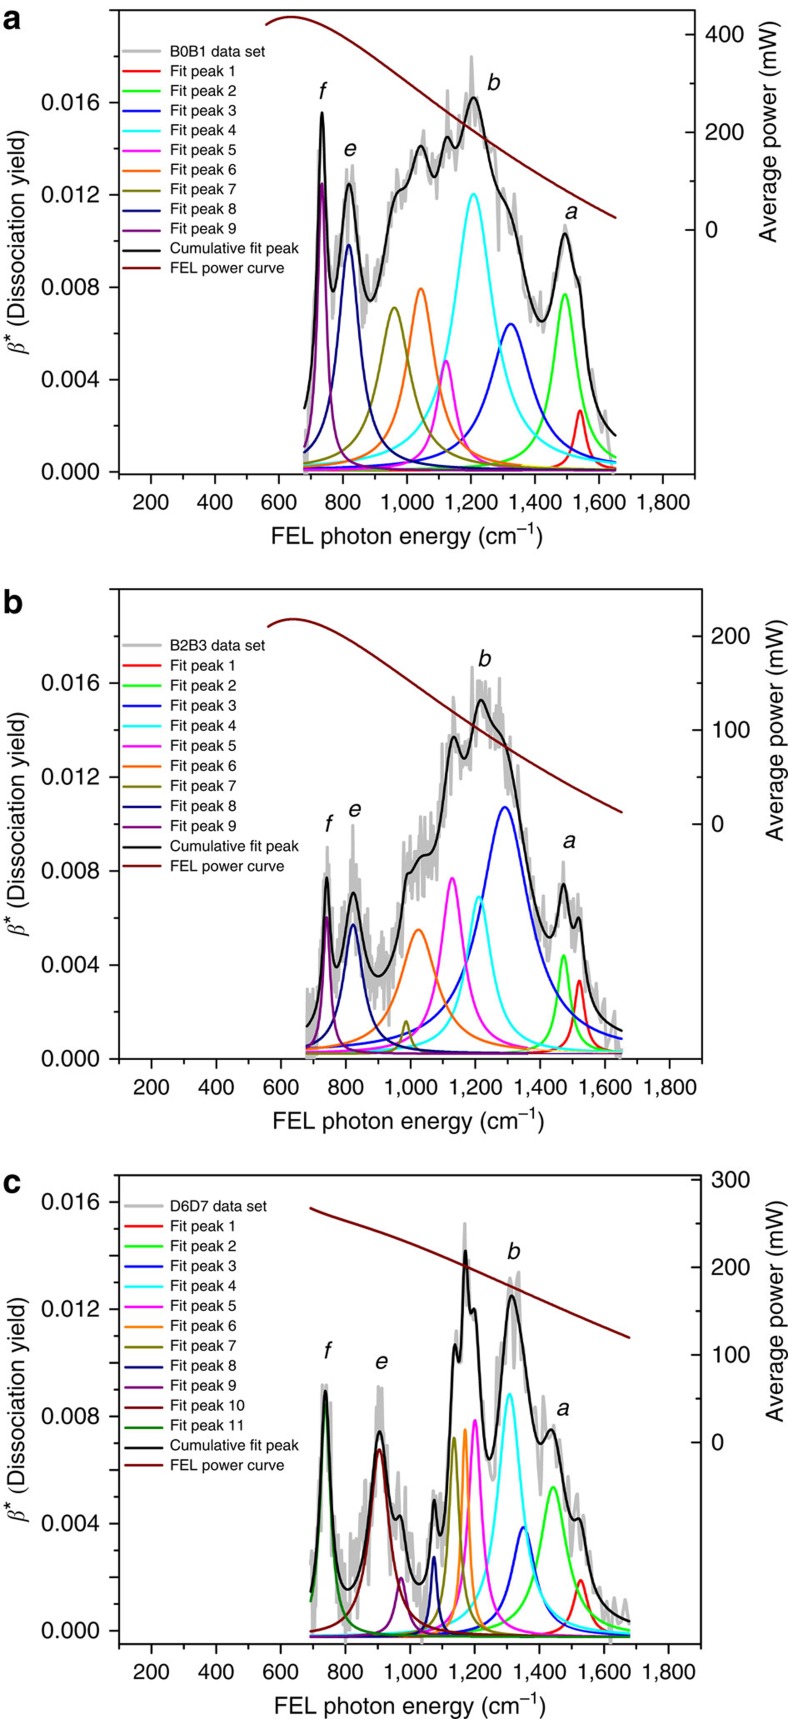
Partial action spectra without FEL power curve correction.Picene+ spectra (non-normalized) are retrieved from data sets consisting of two averaged FEL spectral scans along the depicted range of parent and product ions recorded without (a, 0 dB; B0B1), and with (b, 3 dB; B2B3) FEL power level attenuation. The B0B1 power curve is the same as the B2B3 power curve but as twice as high. The B0B1 data set is not part of the final picene+ spectrum of Fig. 3a. The pentacene+ spectrum (non-normalized) is retrieved from a data set (D6D7) of two averaged FEL spectral scans of parent and product ions (c). The FEL power curves are obtained from a polynomial fit to power-meter readings at the FEL output. The spectral band deconvolutions are summarized in Supplementary Tables 21–23. These fitted peaks differ from those reported in Fig. 3 since they belong to partial spectra featuring lower signal-to-noise levels.